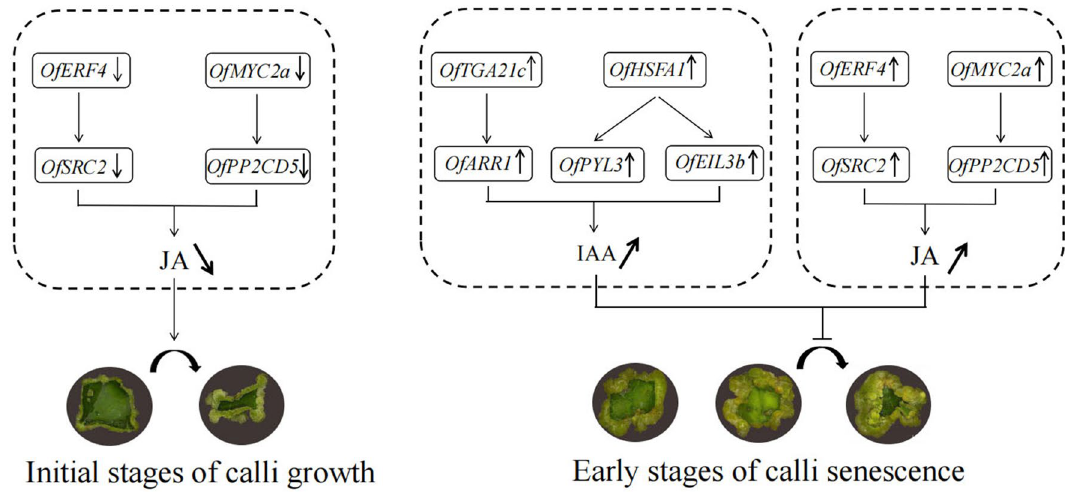
Figure 7. Proposed model of callus proliferation regulation in O. fragrans .